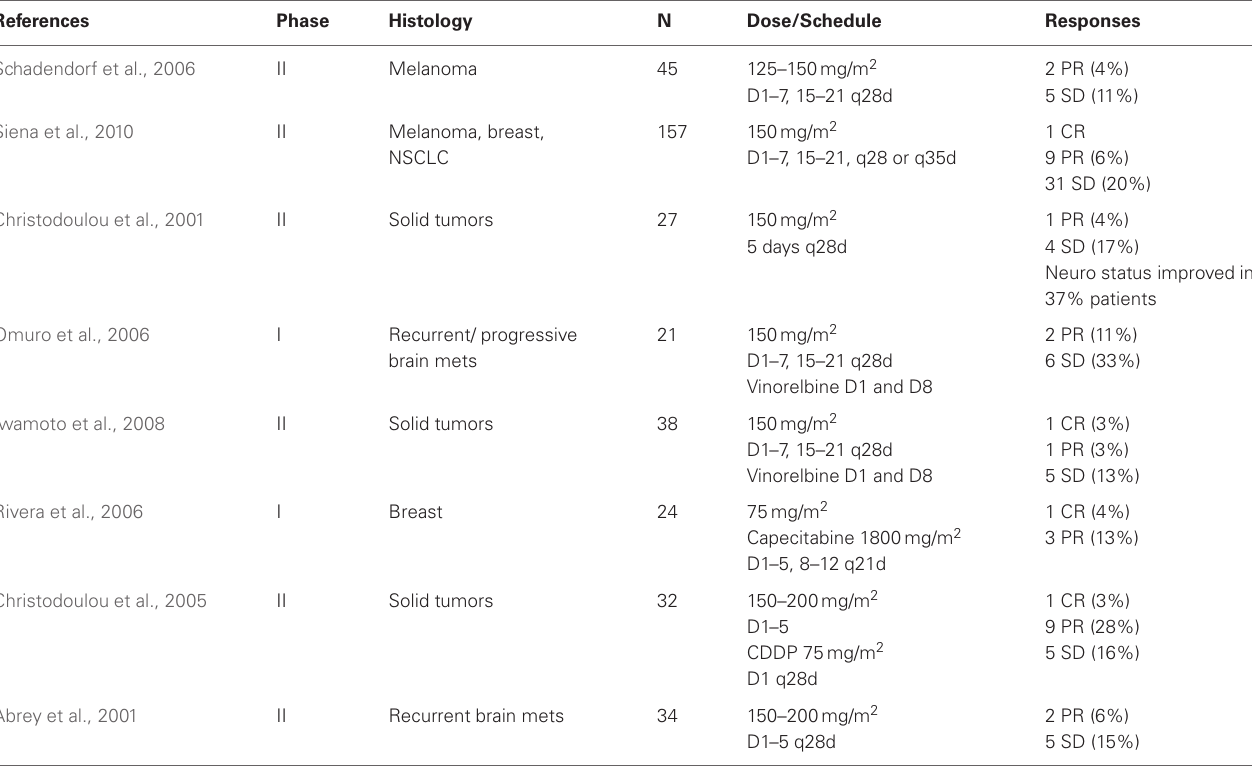
Table 2 | Results of TMZ treatment for established brain